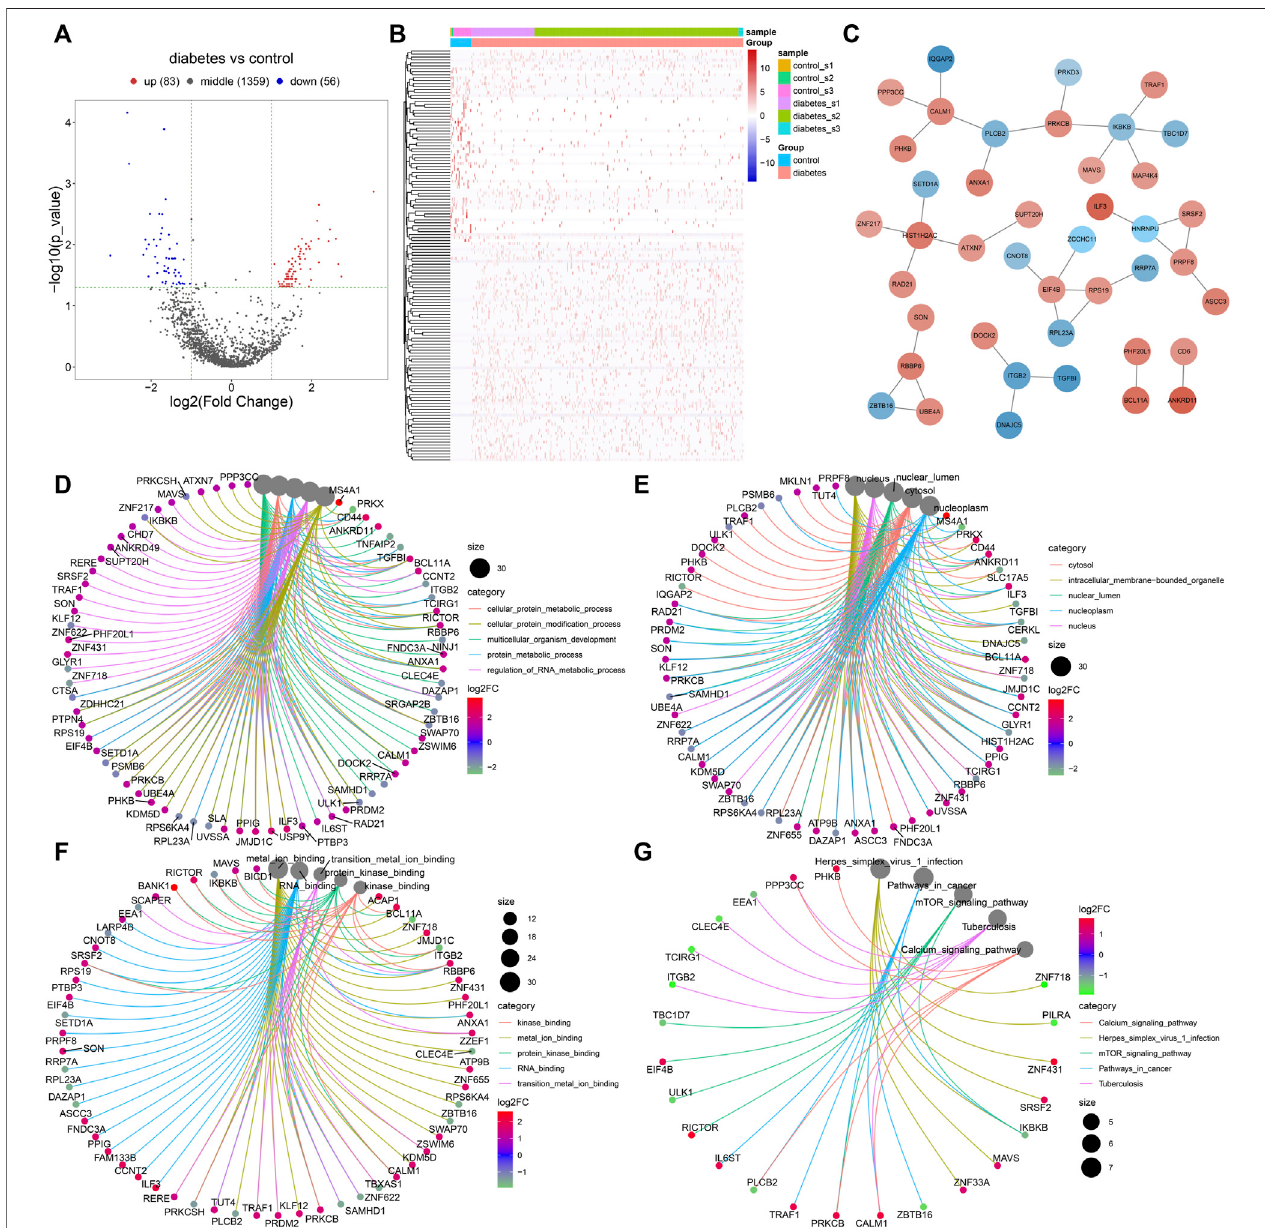
FIGURE 7 | Identi fi cation of differentially expressed marker genes of immune cells in diabetic nephropathy and analysis of their biological implications. (A) Volcano diagram showing the expression differences in marker genes of immune cells between the diabetic kidney specimens and controls. Blue: down-regulation; red: up-regulation and grey: no signi fi cance. (B) Hierarchical clustering analysis visualizing the expression patterns of differentially expressed marker genes of immunecellsbetweendiabetickidneyspecimensandcontrols.Blueindicatesdown-regulationandredindicatesup-regulation. (C) ThePPInetworkbasedon the differentially expressed marker genes of immune cells. The depth of the color of bubble was proportional to |log2fold-change|. Blue indicated down-regulation and red indicated up-regulation. (D) Biological processes, (E) cellular components, (F) molecular functions, and (G) KEGG pathways enriched by the differentially expressed marker genes of immune cells. The size of the bubble was proportional to the number of enriched genes.